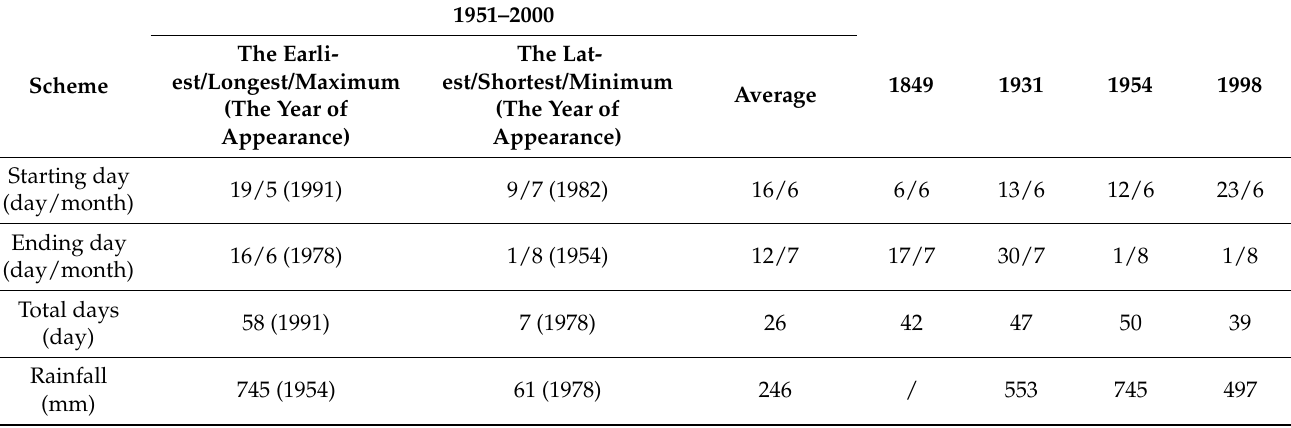
Table 2. Features of Meiyu in several great flood